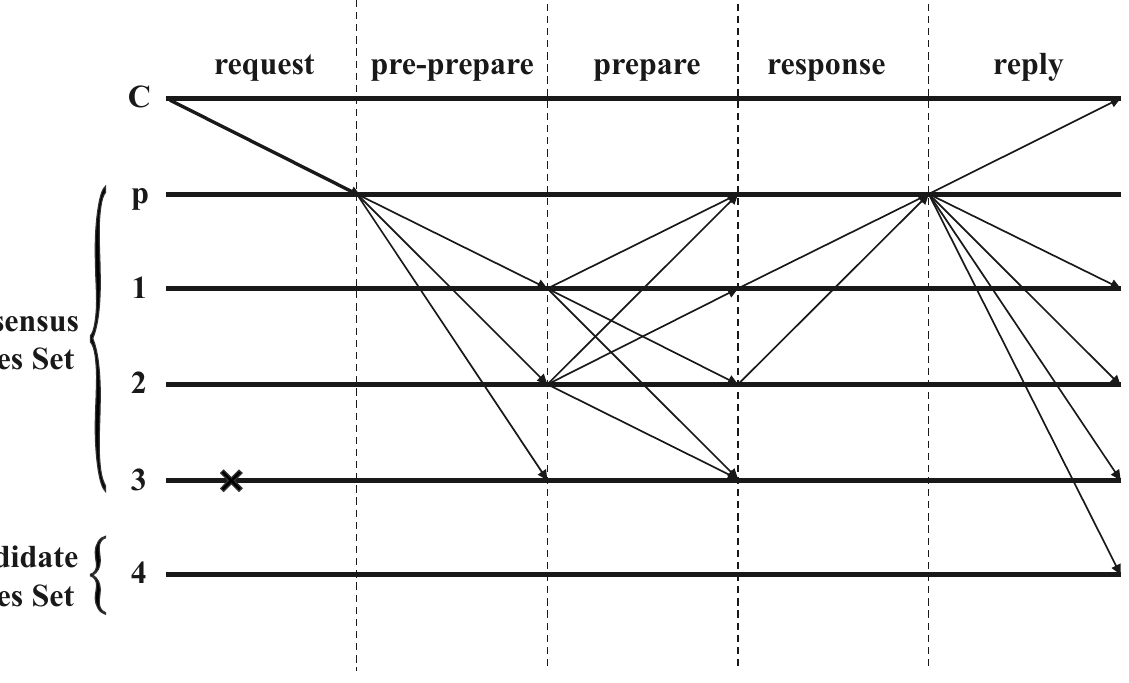
Figure 3. SG-PBFT operating diagram.